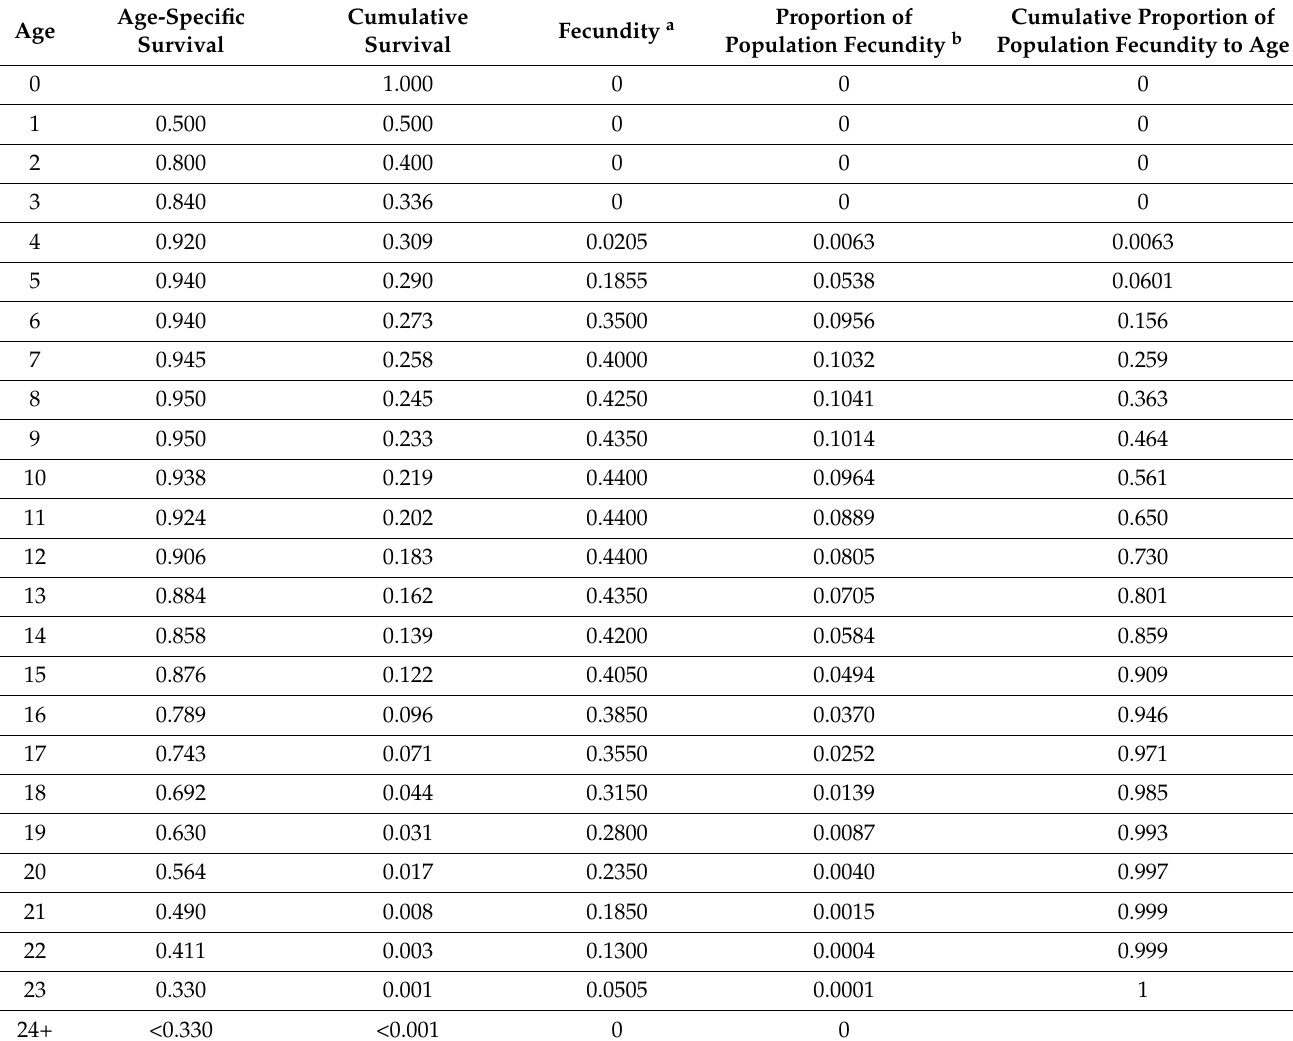
Table 1. Equilibrium life table for female northern fur seals (adapted from